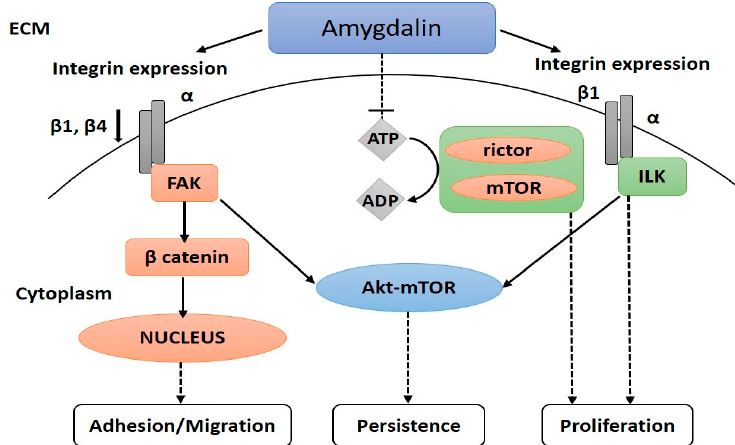
Figure 4. Amygdalin’s impact on Akt ‐ mTOR signaling and β 1 and β 4 integrin expression. Lung cancer cell adhesion, migration, and proliferation are slowed when ILK and FAK expression is suppressed. The growth and proliferation of cancer cells are regulated by a phosphorylation cascade that includes the mTOR/Rictor complex, which amygdalin can